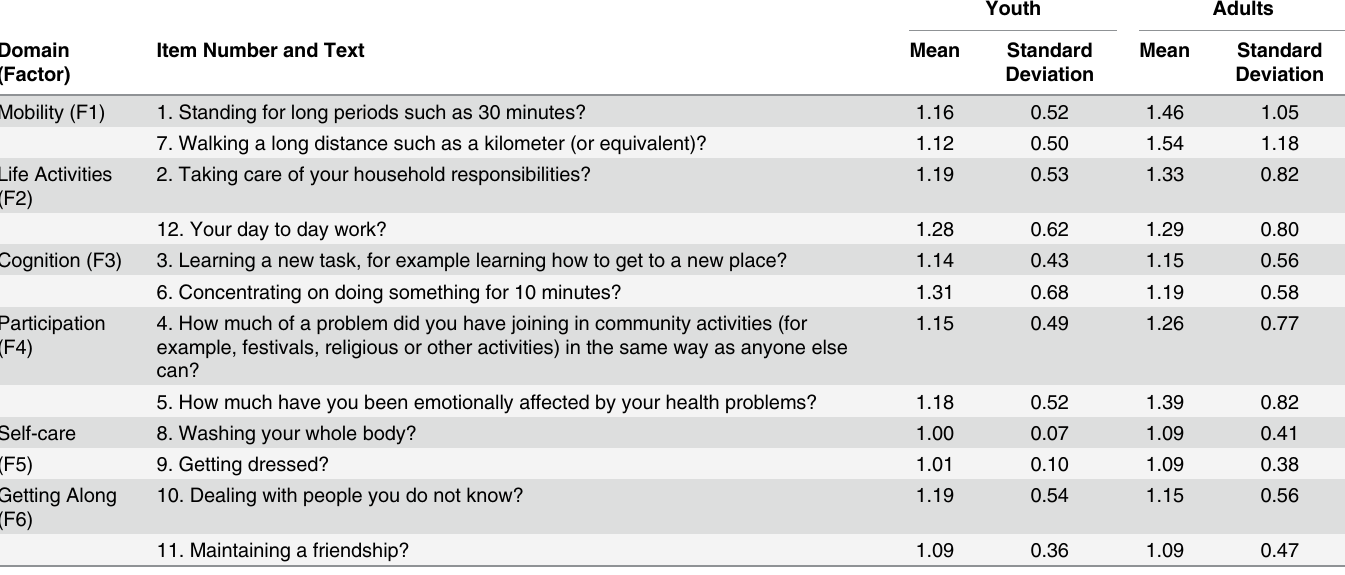
Table 1. Description of the WHODAS 2.0